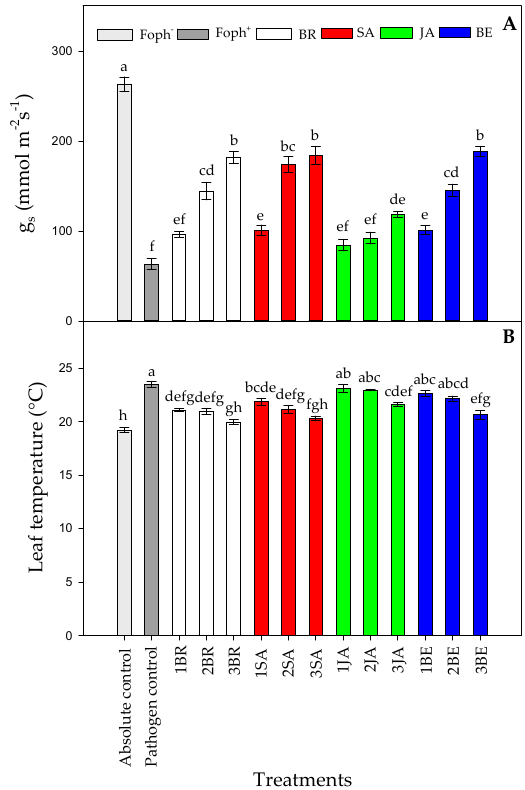
Figure 5. Effect of the different number of sprays (0, 1, 2 and 3 applications) of synthetic elicitors (Salicylic acid (SA), jasmonic acid (JA), Brassinosteroids (BR), or botanical extracts (BE)) on stomatal conductance (g s ) ( A ) and leaf temperature (T L ) ( B ) in Fusarium oxysporum f. sp. physali (Foph + ) infected cape gooseberry ( Physalis peruviana L.) plants at 50 DAI. Data represent the average of ten plants ± SE per treatment ( n = 10). Bars followed by different letters indicate statistically significant differences according to the Tukey test ( p ≤ 0.05).